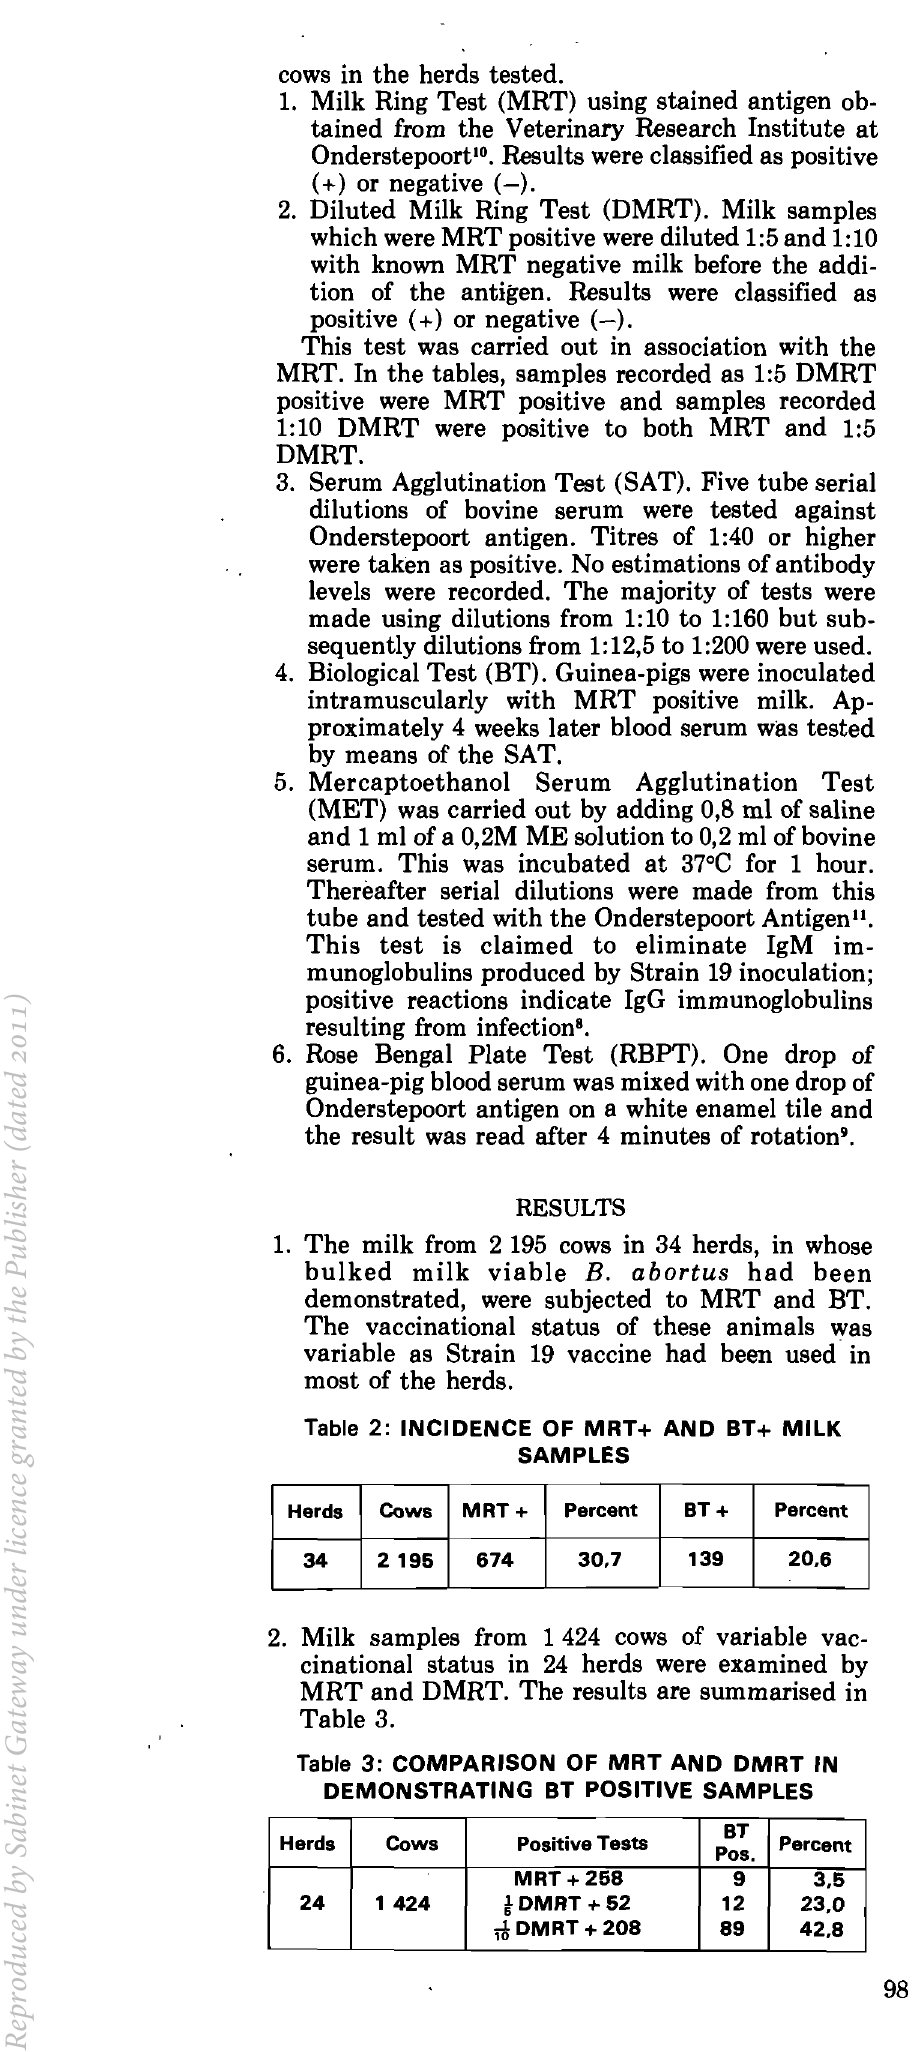
Table 4: USE OF MRT, DMRT AND BT TO~IDENTIFY INFECTED COWS IN A SINGLE HERD